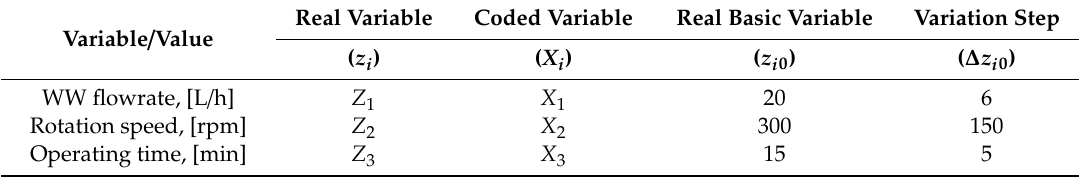
Table 3. The codification of independent variables in the active central composite rotatable 2 3 design.